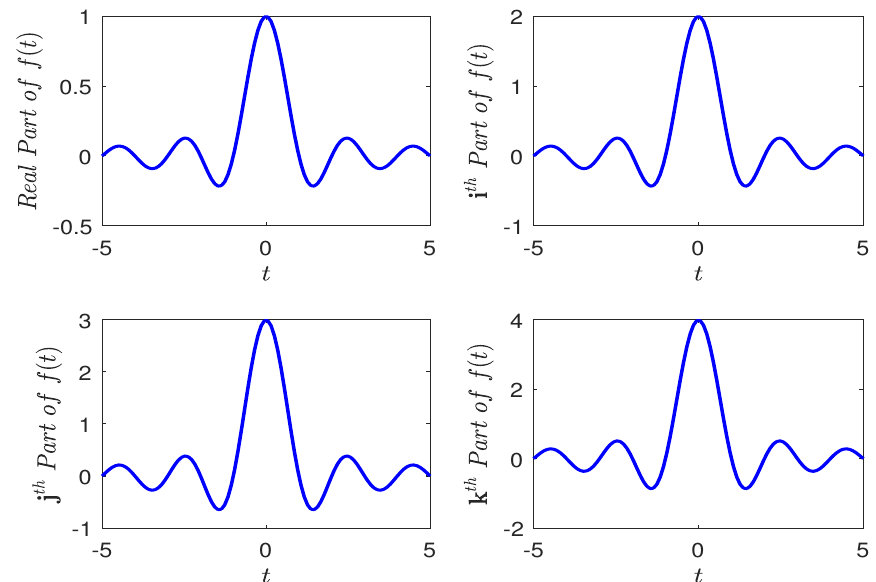
Figure 1. The quaternion-valued signal f ( t ) = ( 1 + 2 i + 3 j + 4 k ) sin c ( t ) .